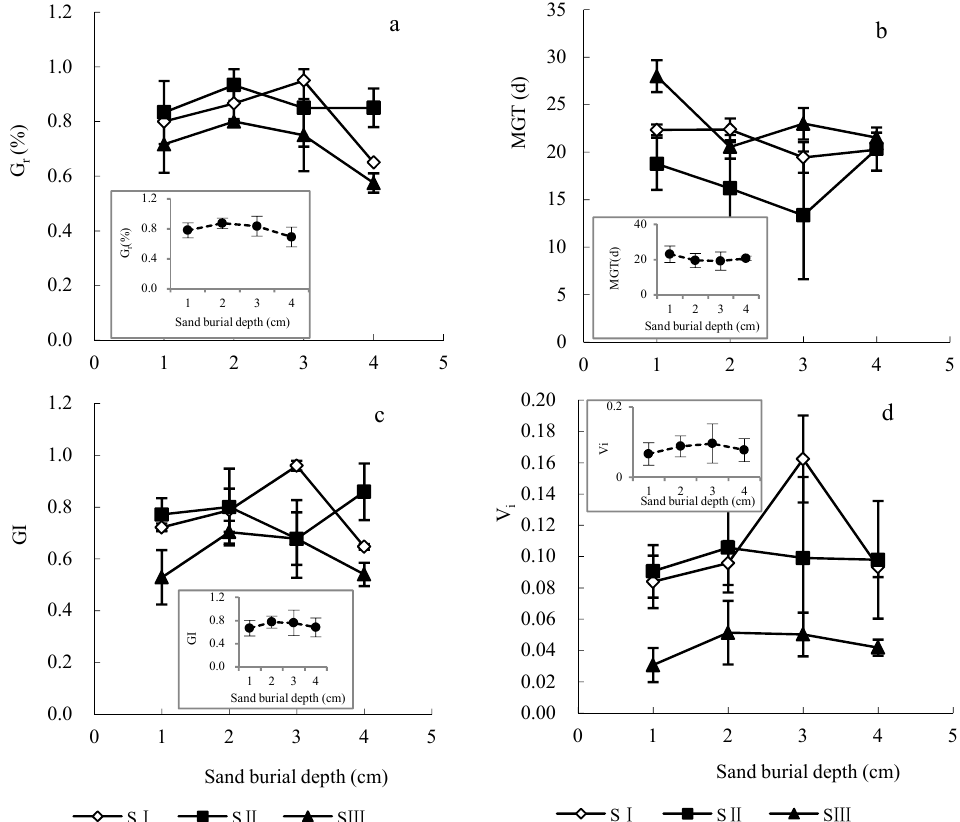
Figure 2. Effects of seed size and sand burial depth on seed germination of Pinus thumbergii. G r ( a ): germination rate; MGT( b ): mean germination time; GI ( c ): germination index; V i ( d ): vigor index. SI: large seeds; SII: medium seeds; SIII: small seeds. Values are means ± standard deviation (SD). Inset panel: variation of mean values of three seed size groups with sand burial depth for G r , MGT, GI, and V i .